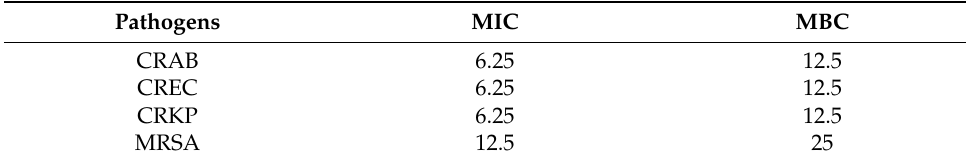
Table 2. MIC (mg/)mL and MBC of compound ( 3 ) against XDR